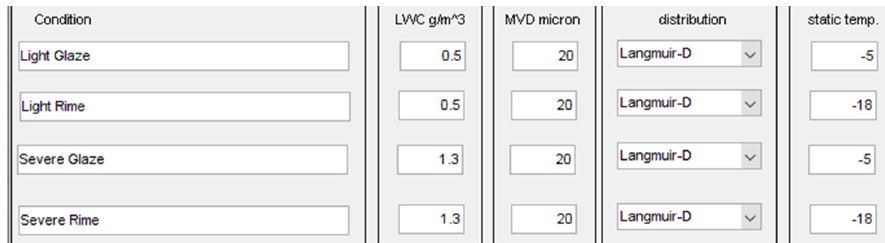
Figure 6. Mesh around the 5-h severe rime ice blade.